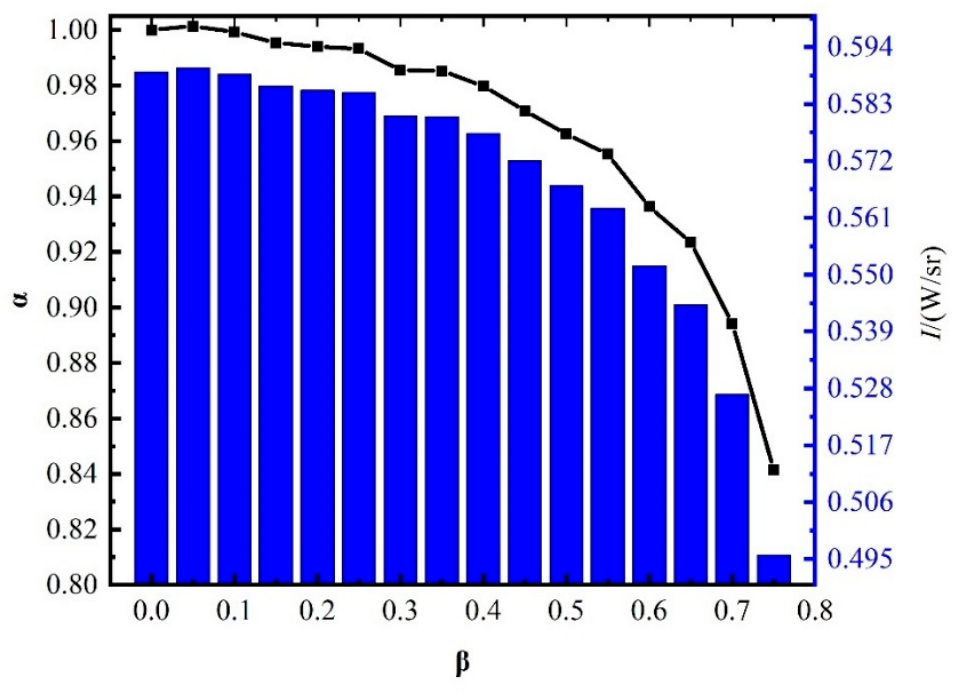
Figure 5. The correction coefficient α at different values of β and the spectrally integrated radiant intensity in the 3.5~4.15 μ m band.